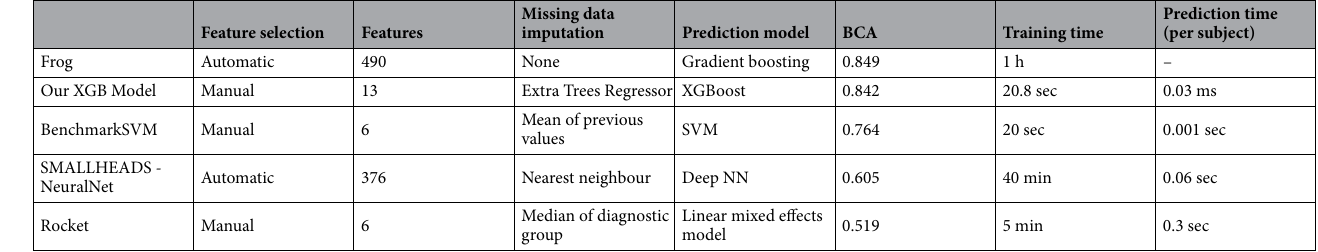
Table 7. Comparison of our model with some of the contestants of TADPOLE Challenge 52